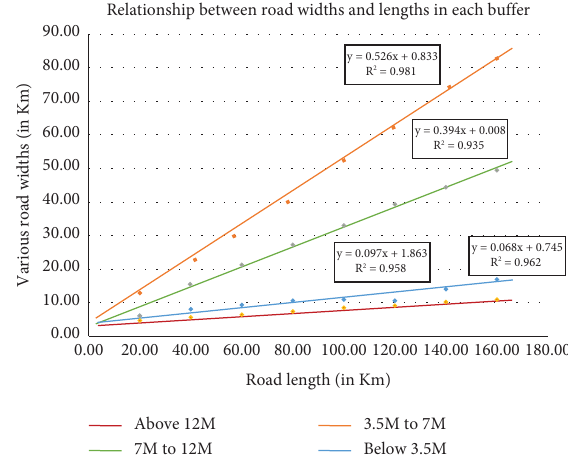
Figure 7: Relationship between road widths and lengths in each bufer.